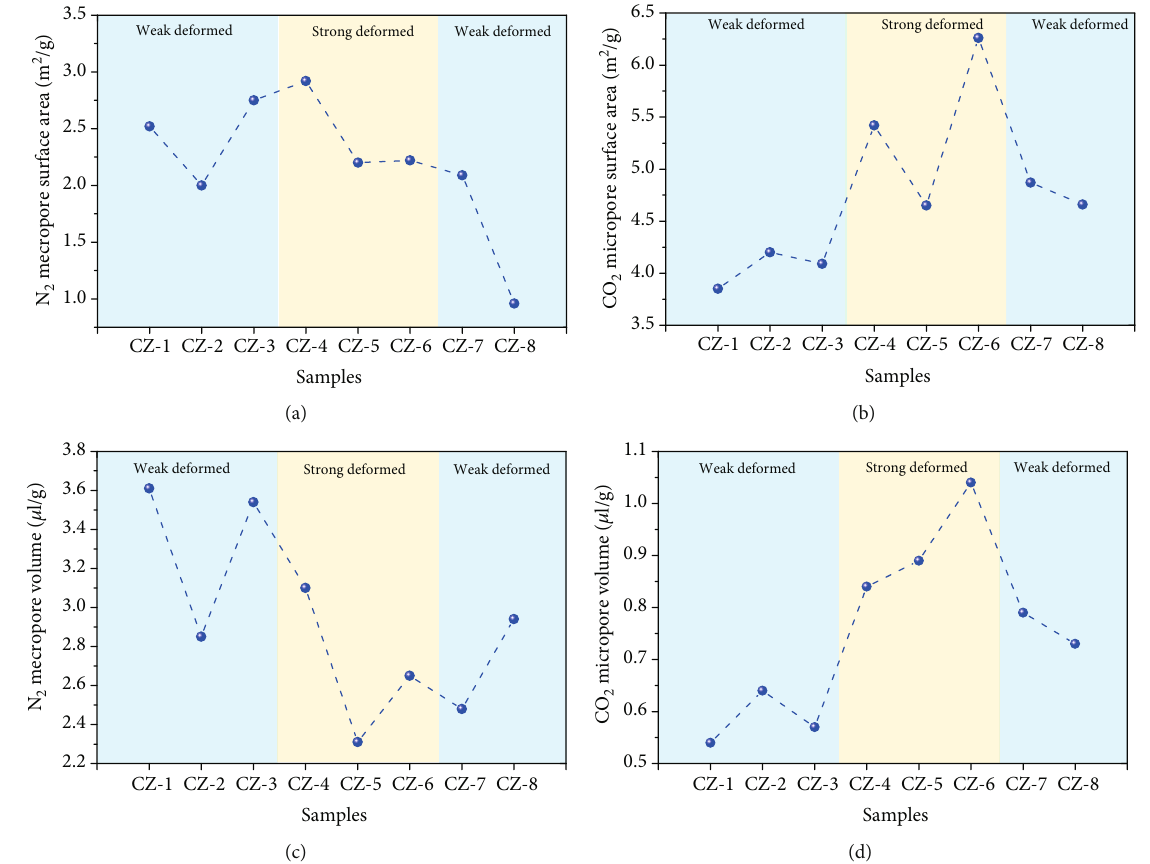
Figure 10: PV and SSA of the Lujiaping shale from the data of LPGA